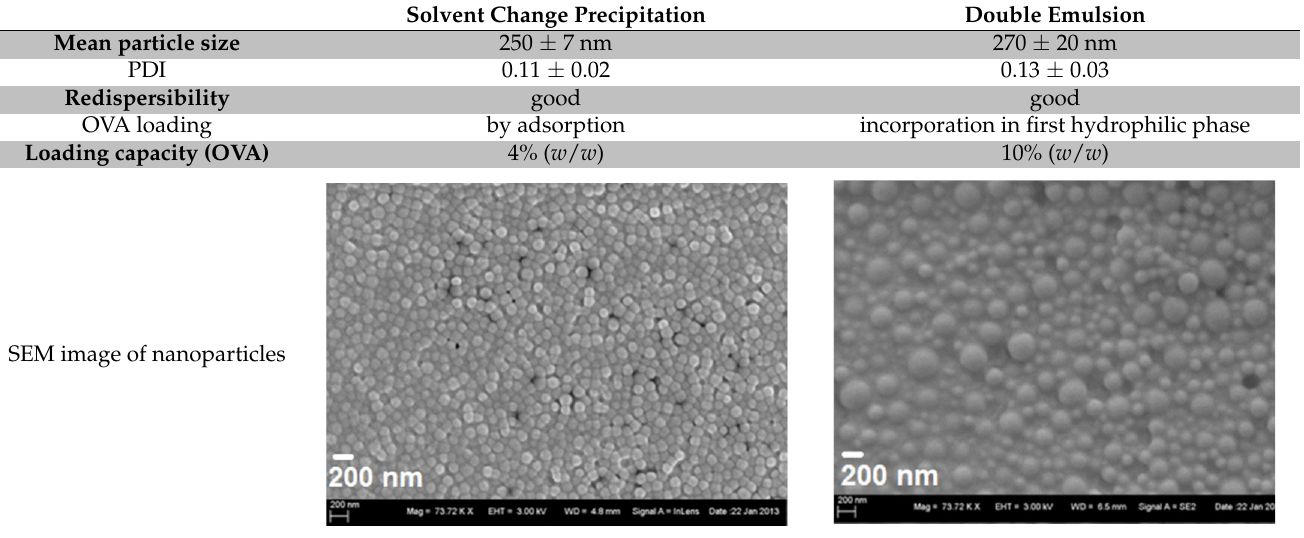
Table 1. Characteristics of solid nanoparticles produced with the different techniques (manual